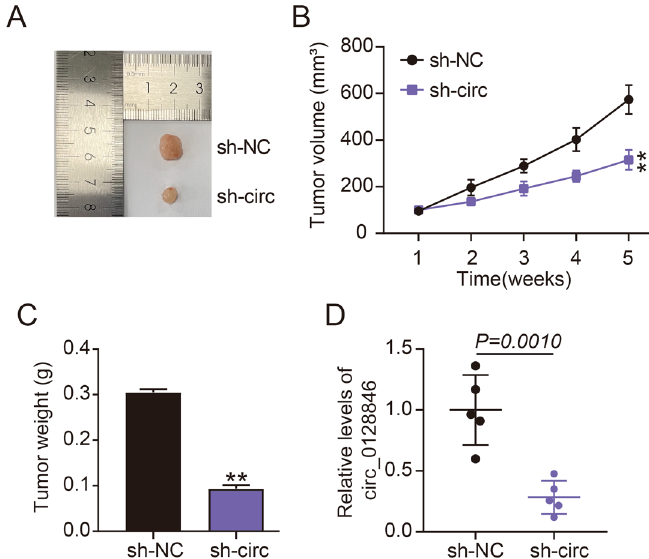
Figure 3. Circ_0128846 absence restrained tumor growth in vivo. ( A – C ) SW1990 cells infected with lentivirus of sh-circ or sh-NC were injected into nude mice to construct xenograft models. ( A ) Representative images of tumor tissues from sh-NC or sh-circ group. ( B ) Tumor volume was measured weekly to assess tumor growth. ( C ) After tumor growth for 5 weeks, tumor tissues were excised for weight measurement. ( D ) circ_0128846 expression in sh-NC and sh-circ group was detected by RT-qPCR. ** P < 0.001 relative to